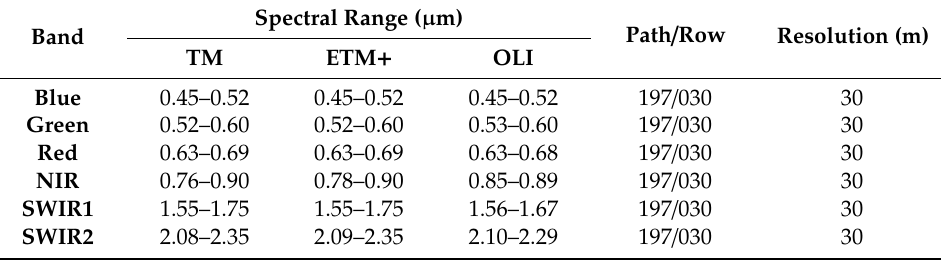
Figure 2. Landsat data availability covering the study area during 2002–2016. ( a ) Number of Landsat 5, 7 and 8 images per year; ( b ) Number of missing values in all Landsat images per year over the study period. Table 1. Information of the Landsat spectral bands used in this study.